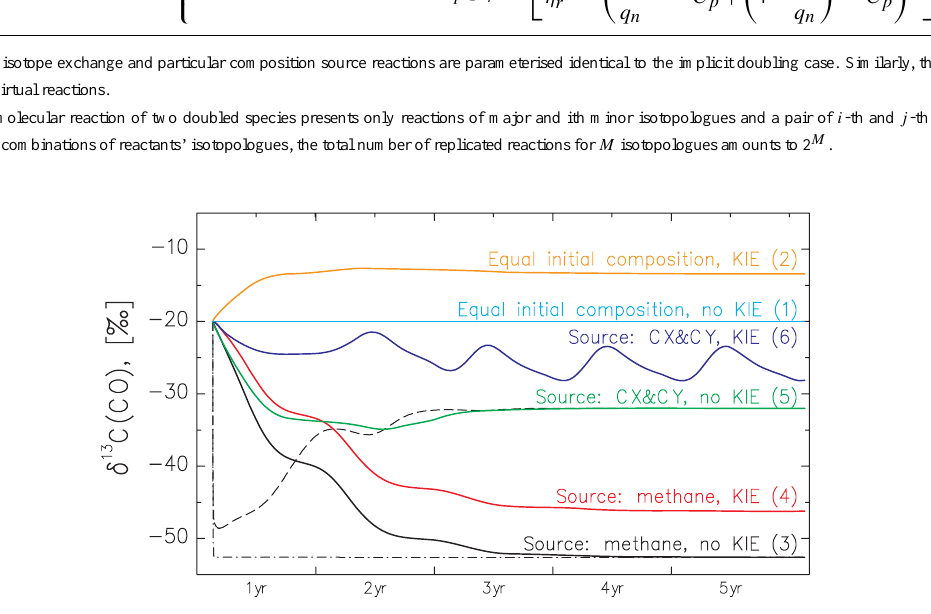
Fig. 3. Carbon monoxide isotopic composition evolution (solid lines) for different simulation setups (1–6) with the prototype mechanism (Fig. 2). Dashed and dash-dotted lines denote the formaldehyde composition for setups 5,6 and 3,4,